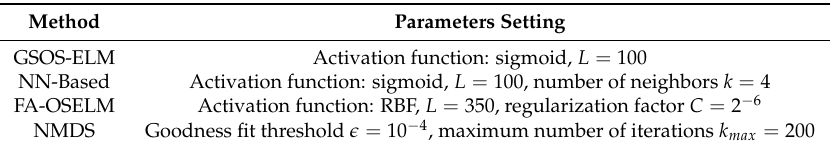
Table 3. Parameters Setting for Proposed Method and Compared Methods.